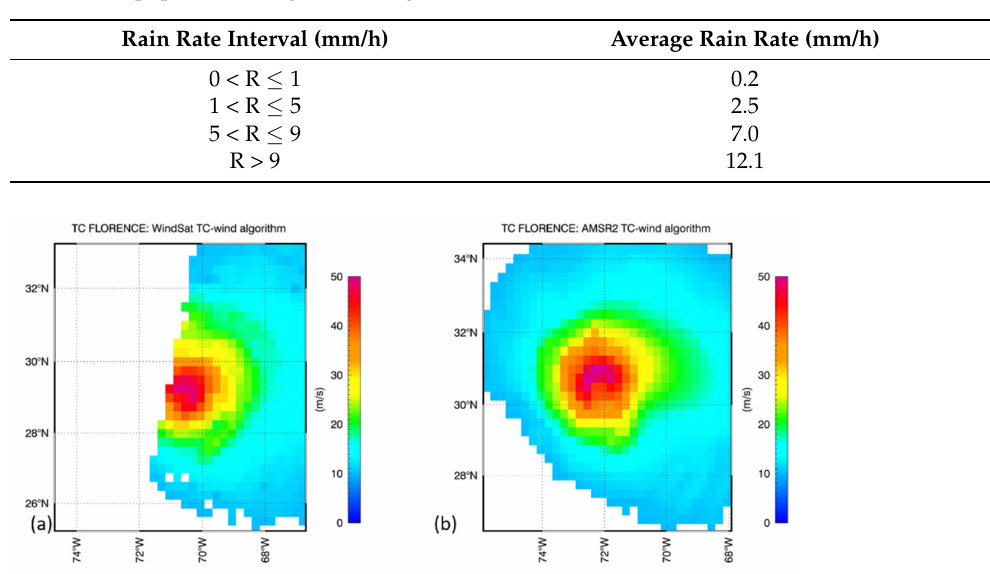
Table 1. Rain rate intervals used for training the WindSat TC-wind algorithm. The 2nd column contains the population weighted average in each interval.